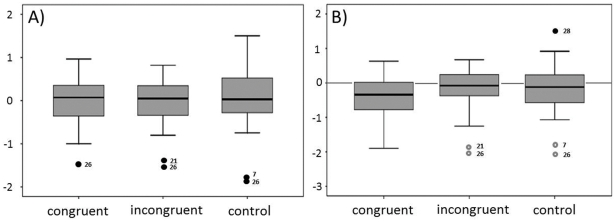
Definition of outliers.For each subject and cueing condition (i.e. congruent, incongruent, control), slopes were calculated using robust regression analysis. Slopes were subjected to a 3×2-way rmANOVA with within-factor “cue” and between-factor “sex”, and the resulting residual distribution was examined. Panel (A) shows condition-wise boxplots of the residuals. Cases deviating 2.5 times the standard deviation from the mean of the global residual distribution (# 7, 21, 26) were defined as outliers. Condition-wise boxplots over the actual slopes confirmed this outlier definition as accurate but less conservative (B, outliers shown in grey).